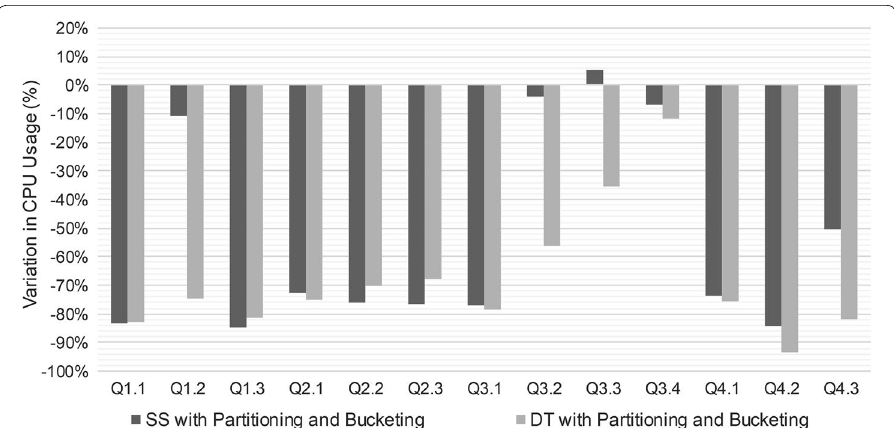
Fig. 10 CPU usage: multiple partitioning by “Od_Year” and “S_Region” and bucketing by “Suppkey” (Presto; SF =